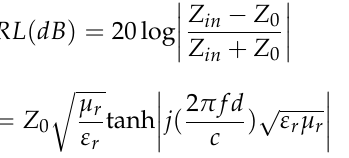
where Z in and Z 0 represent the input impedance of the absorber and air, µ r and ε r are complex permeability and permittivity, f is the frequency of the incident EMW, d is the thickness of the absorber, and c is the speed of light in vacuum. Figure 7 shows the RL value of the samples as a function of frequency and thickness. A minimum reflection loss ( RL min ) value of − 5.4 dB is obtained for S1 at 15.6 GHz with a thickness of 3 mm (Figure 7a,d), while the RL min value for S2 is − 5.2 dB at 6.6 GHz with a thickness of 5 mm (Figure 7b,e). For S1 and S2, the RL min was obtained at different frequencies that do not shift with thickness, which suggests that different EMW absorption mechanisms may exist for S1 and S2, respectively. Compared with S1 and S2, S3 exhibits significantly enhanced EMW absorption performance with a wide effective absorption bandwidth (EAB, expressed in f e ) of 3.85 GHz at 2.28 nm as well as small RL min value of -17.4 dB at 13.44 GHz (Figure